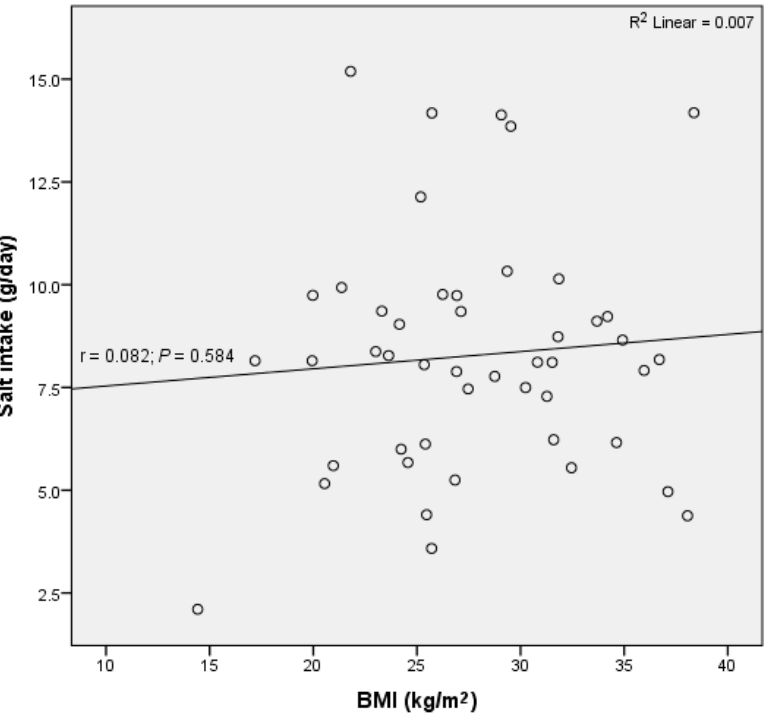
Figure 4. No significant correlation between daily salt intake and body mass index (BMI) was observed in residents of retirement homes in the Goriška region.